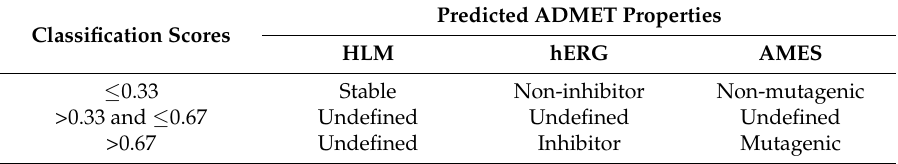
Table 5. The meaning of classification score range values for ADMET properties using Program ACD/Percepta.